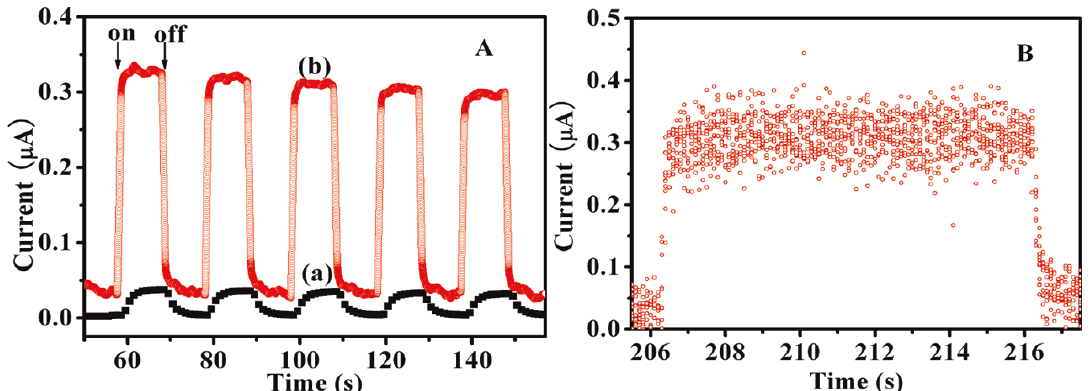
Figure 26. ( A ) Photocurrent response of (a) the pristine AZO and (b) GO-AZO film at a +0.5 V bias in 0.1 M KCl aqueous solution. ( B ) Photocurrent response of GO-AZO in one on/off cycle. (Reprinted from [119]; Copyright 2010, American Chemical